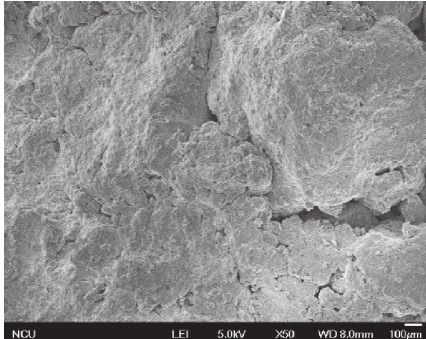
Figure 11: Mesostructure of the laterite without alkaline-solution permeation.